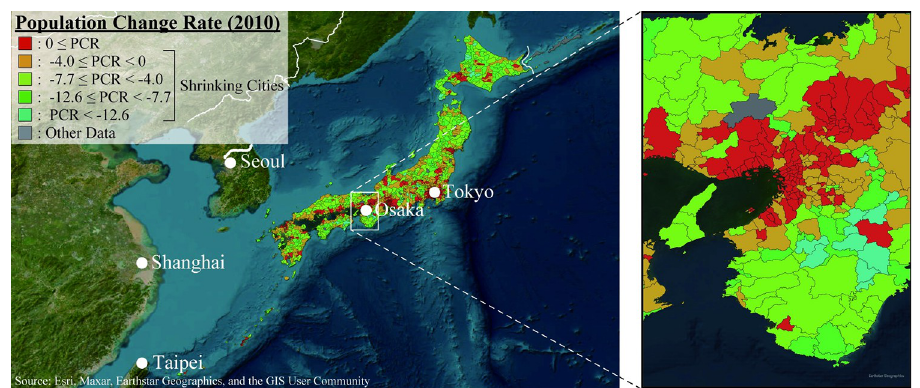
Fig 1. Population change rate in Japanese cities in 2010. In Fig 1, left side map indicates the location of Tokyo and Osaka in major East Asian cities, and right side indicates map focused on the Osaka Metropolitan area. Fig 1 shows the population change in graduated colors from red to blue. The gray color areas are other cities, such as merged cities. Republished from Fig 1 under a CC BY license, with permission from ESRI Japan, original copyright